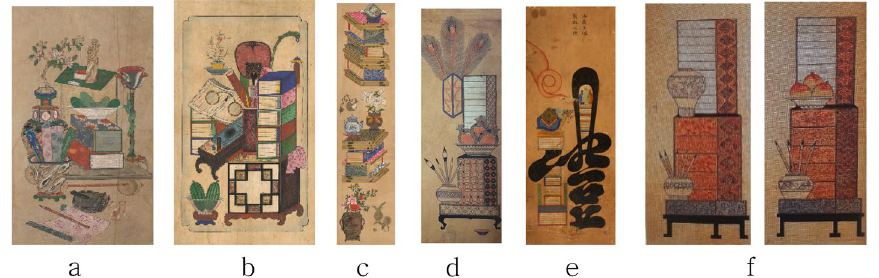
Fig. 3 The formal structure of Chaekgeori. Note. a Multiperspective structure, b Inverse perspective structure, c Isometric perspective structure, d Flat structure, e Complex structure, f Repetitive structure [Source: National museum of Korea collection (2021) (a,b,c); Lee (2015b). The folk painting of Korea 2. koreanology archives (d,f); National Folk Museum of Korea collection (2021)(e)]. This figure (a,b,c)